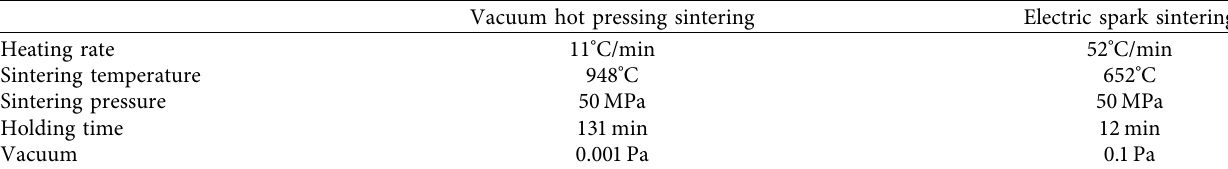
Table 1: Sintering process of ferroelectric ceramic composite